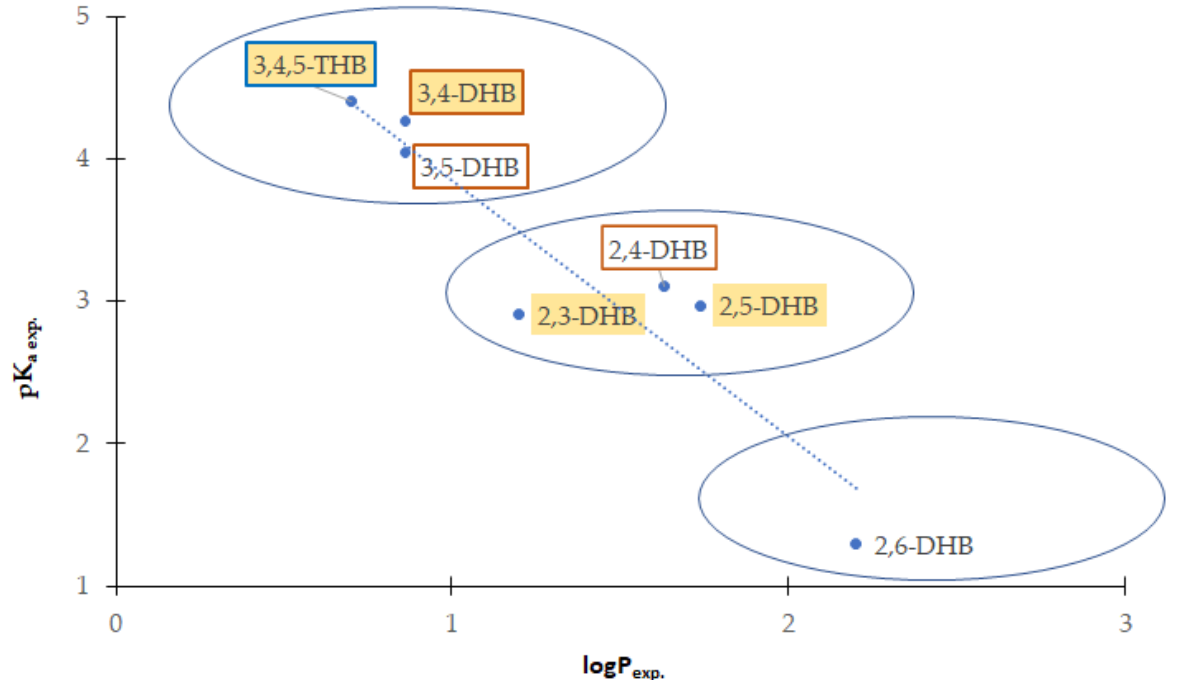
Figure 7. The dependency between the lipophilicity (logP exp. ) and acidity (pK a exp. ) in the series of studied hydroxybenzoic acids (yellow-marked: hydroxybenzoates with the highest antioxidant activity in the group; circled with a red square: compounds with the highest antimicrobial properties against selected microorganisms; circled with a blue square: compounds with the highest cytotoxic activity against selected cancer cell lines).